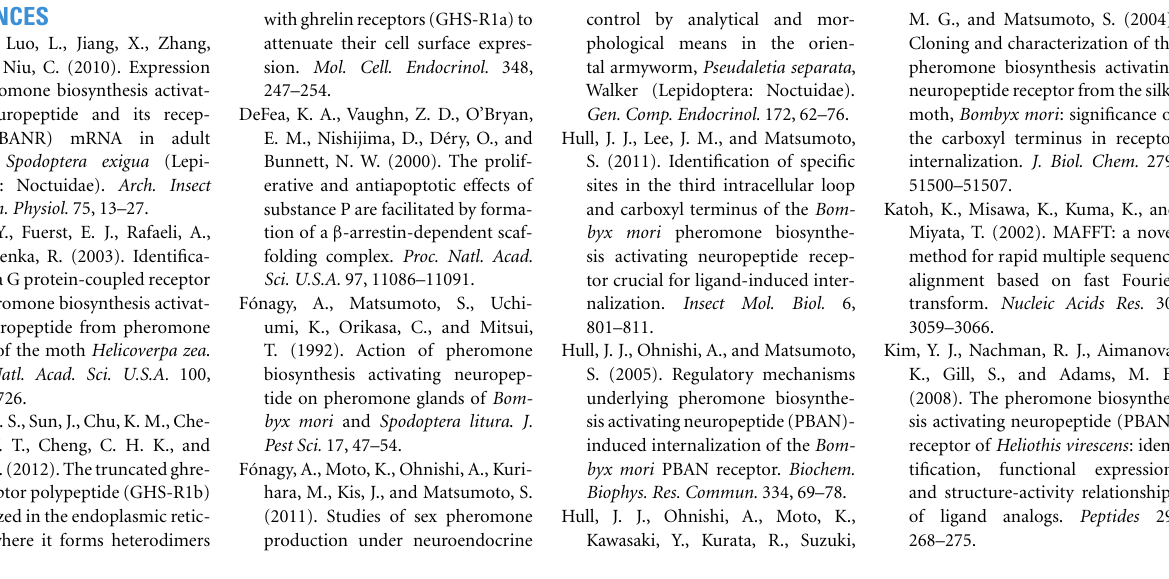
expression plasmid containing EGFP. (B) Ligand-induced internalization of EGFP-tagged PBANR variants. Internalization was triggered with 50nM RR-C10PBAN R2K . Co-localization is indicated by yellow in the merged